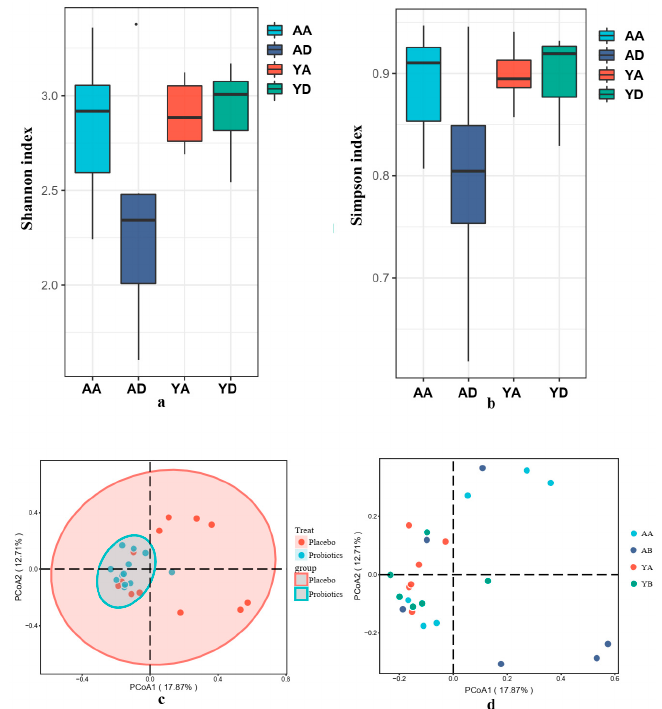
Figure 2. Comparison between the α -diversity indexes and gut microbial population structure of the samples. ( a ) Shannon index; ( b ) Simpson index; ( c , d ) The PcoA of the gut microbial population structure. (Figure 2a,b, AA and AD represent the 0-day and 21-day placebo groups, respectively; YA and YD represent the 0-day and 21-day probiotic groups, respec- tively. The legends of the following results also represent the same